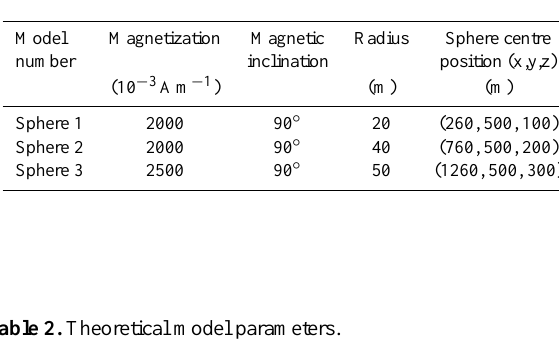
Table 1. Forward model parameters.